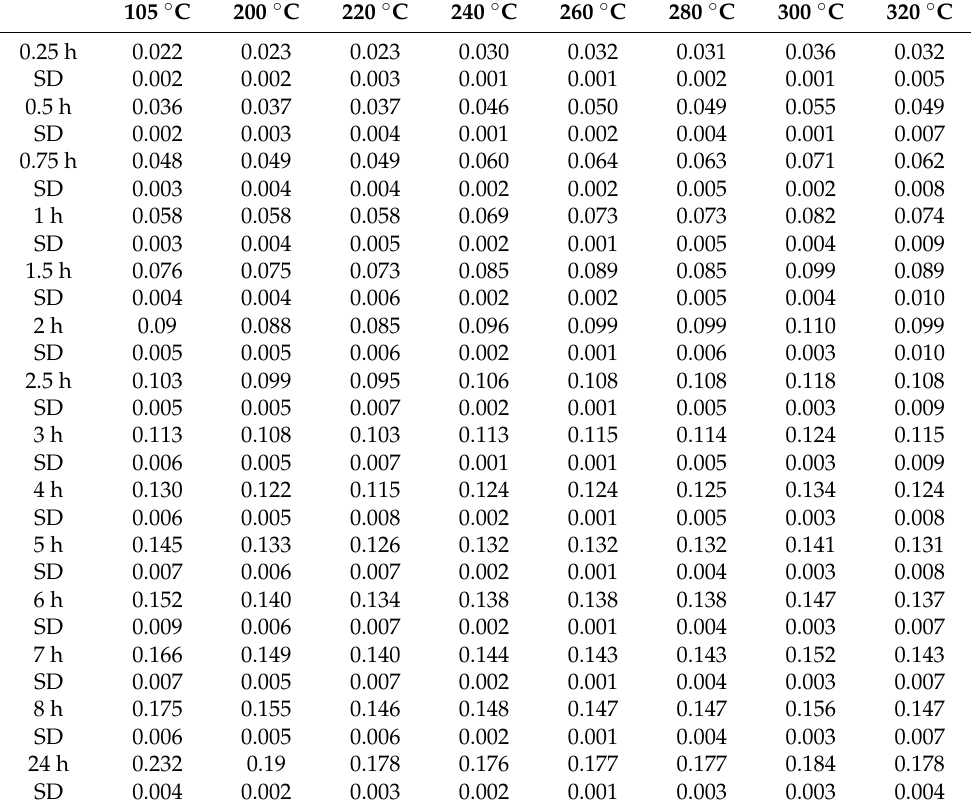
Table 6. Influence of the climatic chamber operation time (CCOT) and the torrefaction temperature on the value of the EMC coefficient for butternut-squash